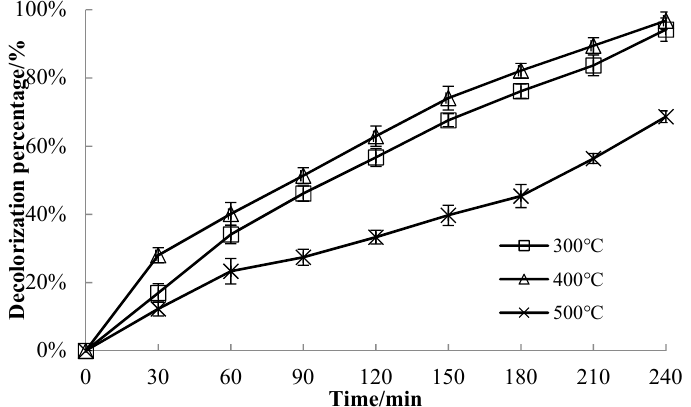
Figure 4. Effect of calcination temperature on the decolorizationefficiency of the MB solution.